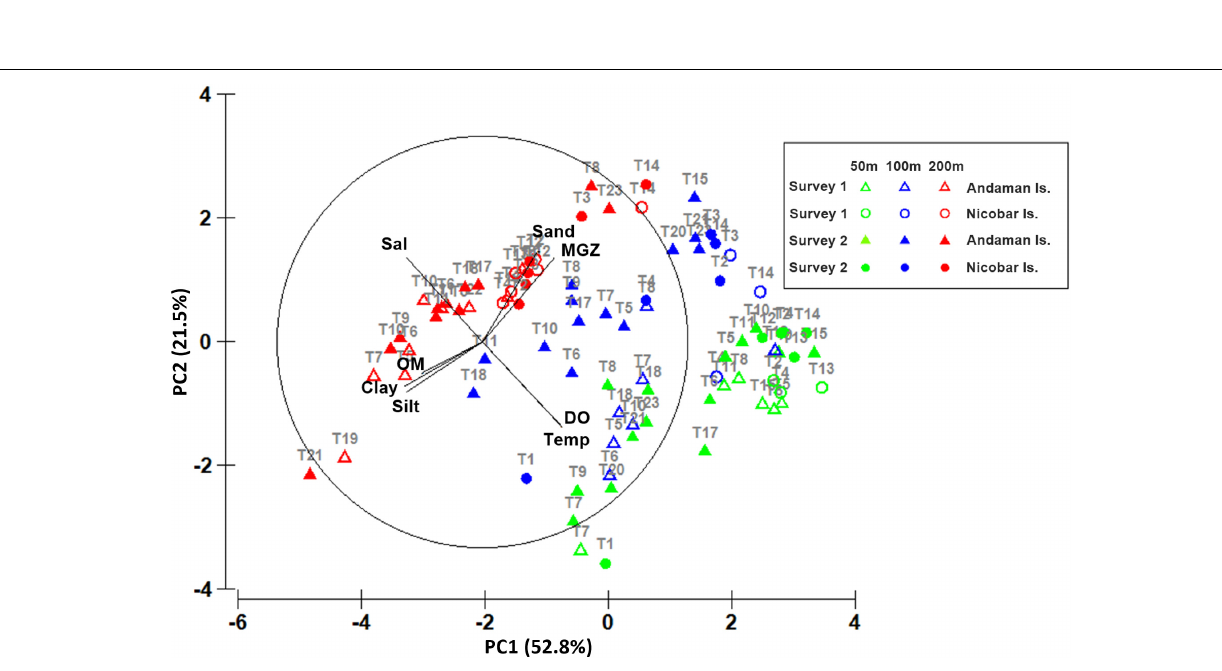
Frontiers in Marine Science |